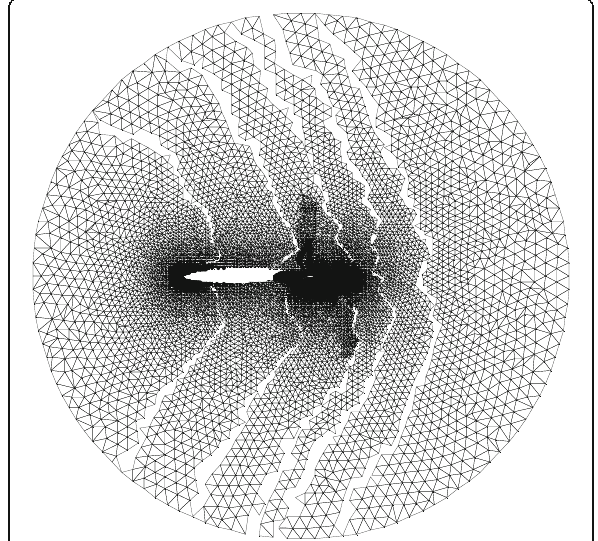
Fig. 12 Multi-element airfoil: gridded subdomains